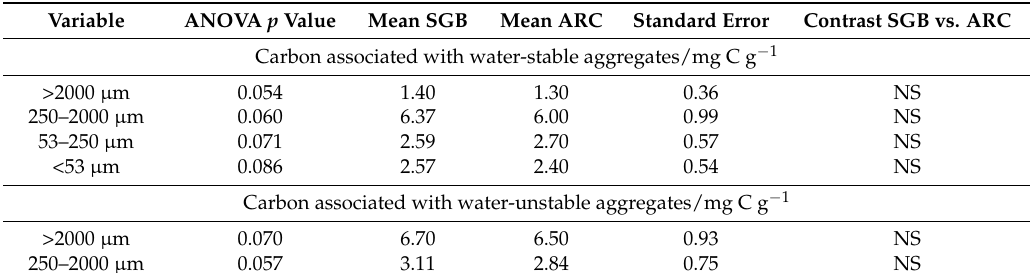
Table 2. ANOVA results from comparison of the concentration of carbon associated with water-stable and water-unstable aggregates in each aggregate size fraction from switchgrass buffer (SGB) and non-buffered annual row crop (ARC).